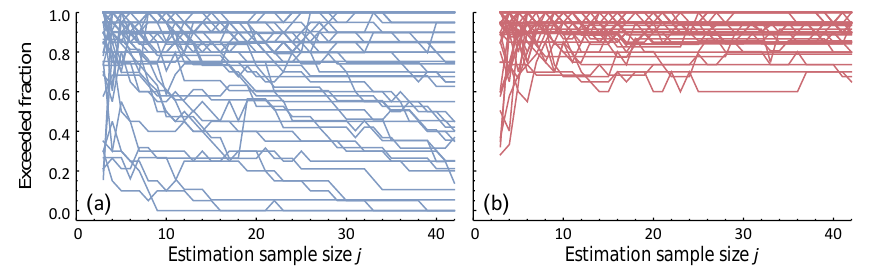
Figure 9. Fraction of each of the 60 stations’ final 20 years with capacity factor exceeding P90 estimate for (a) actual data and (b) randomized data. The count of both years exceeding the estimate and total years were weighted according to the number of underlying